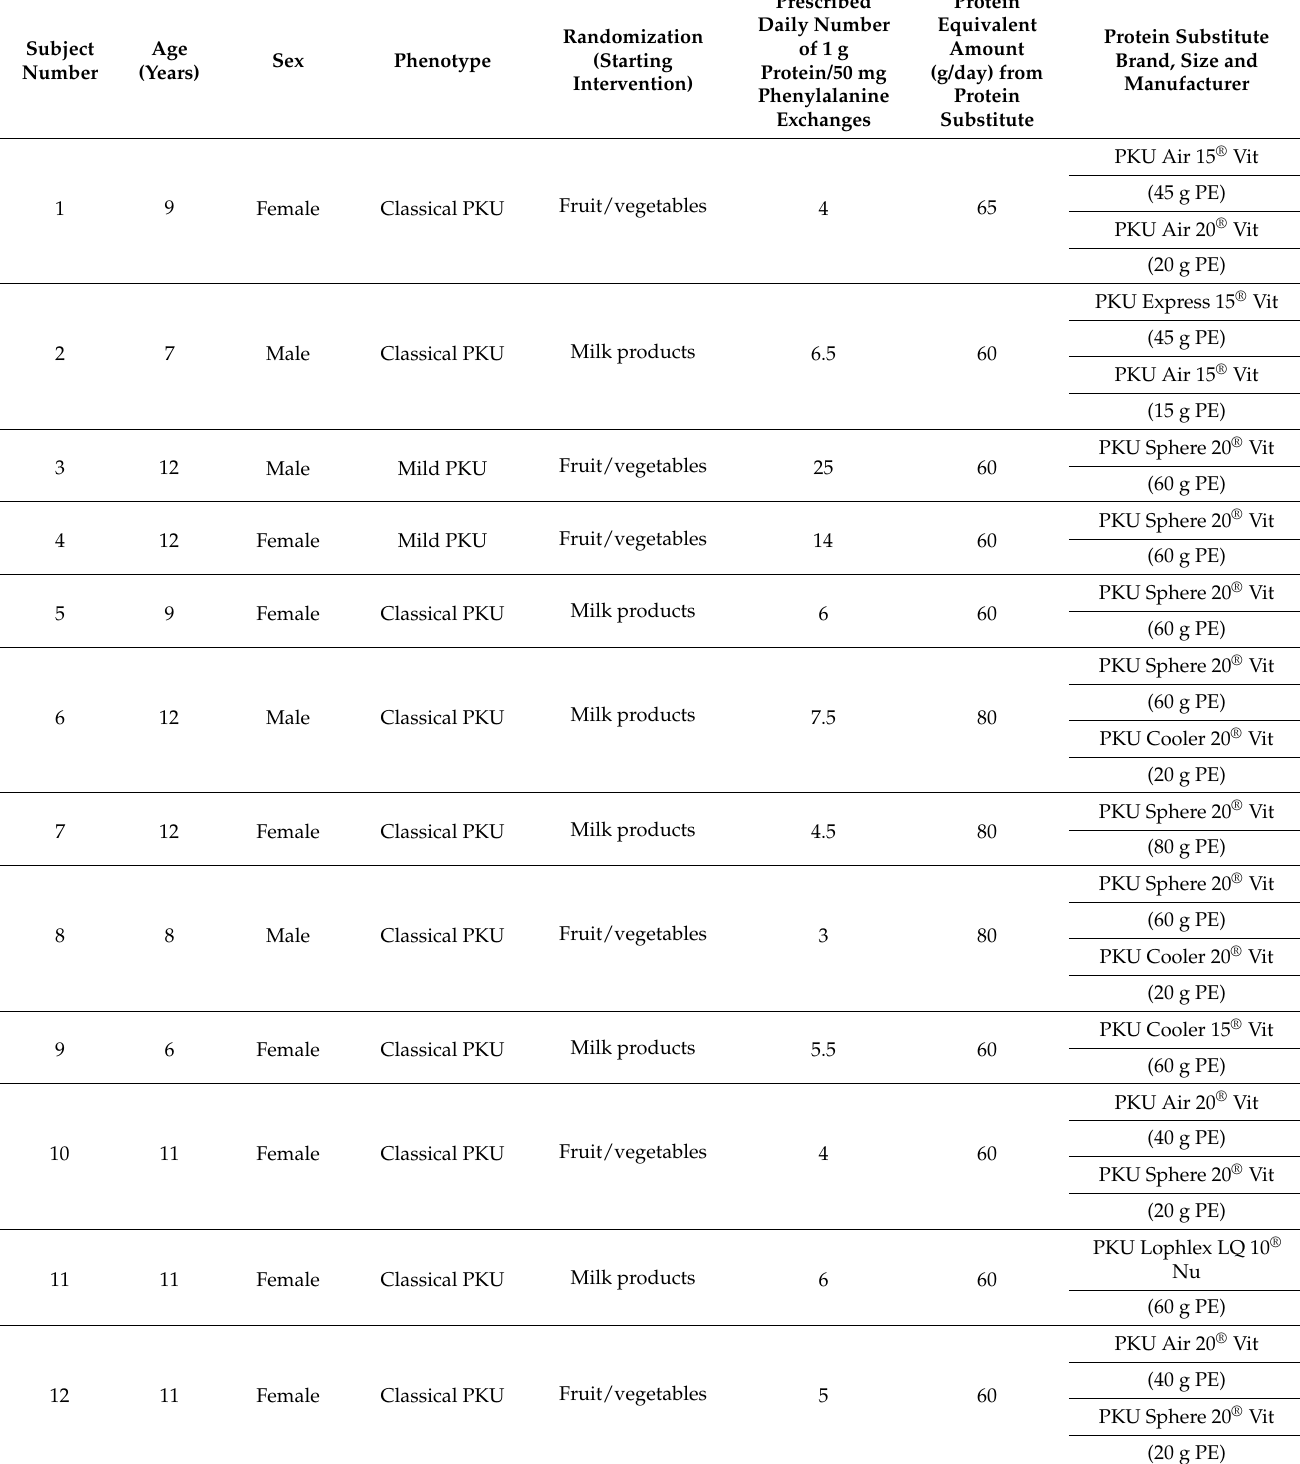
Table 2. Patient characteristics and dietary prescription at the start of the